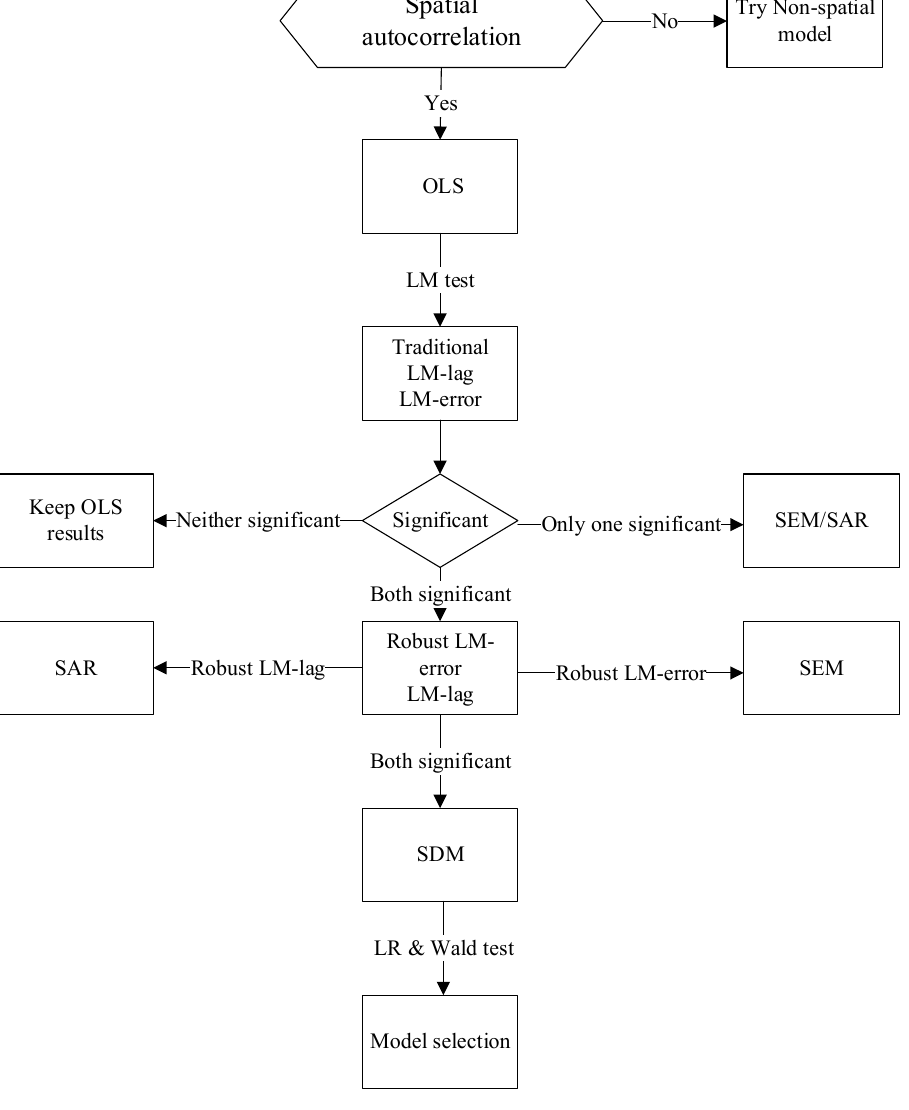
Figure 2. Flow chart of methodology.